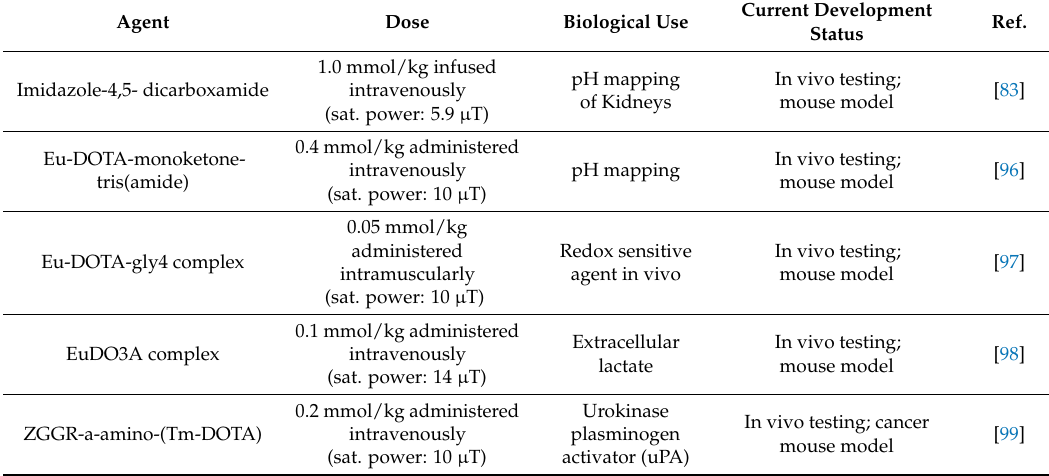
other advanced MR techniques [95]. Table 3. Selected CEST contrast agents discussed in this review, dosages, biologic use, and current development